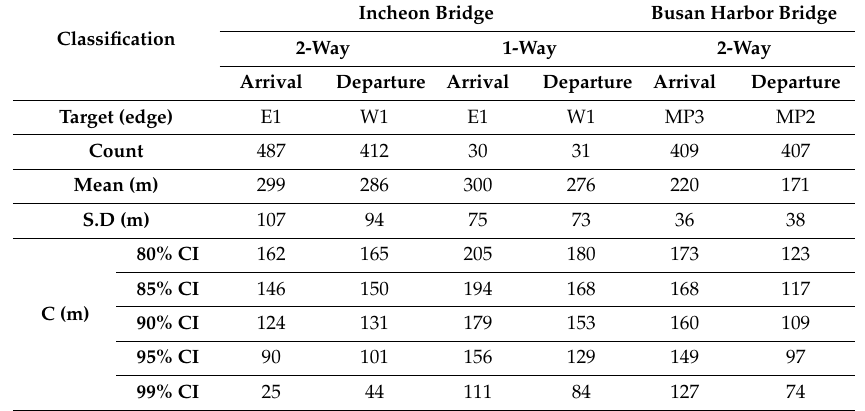
Table 10. Summarized data of distances from ship to bridge pier based on the confidence interval.